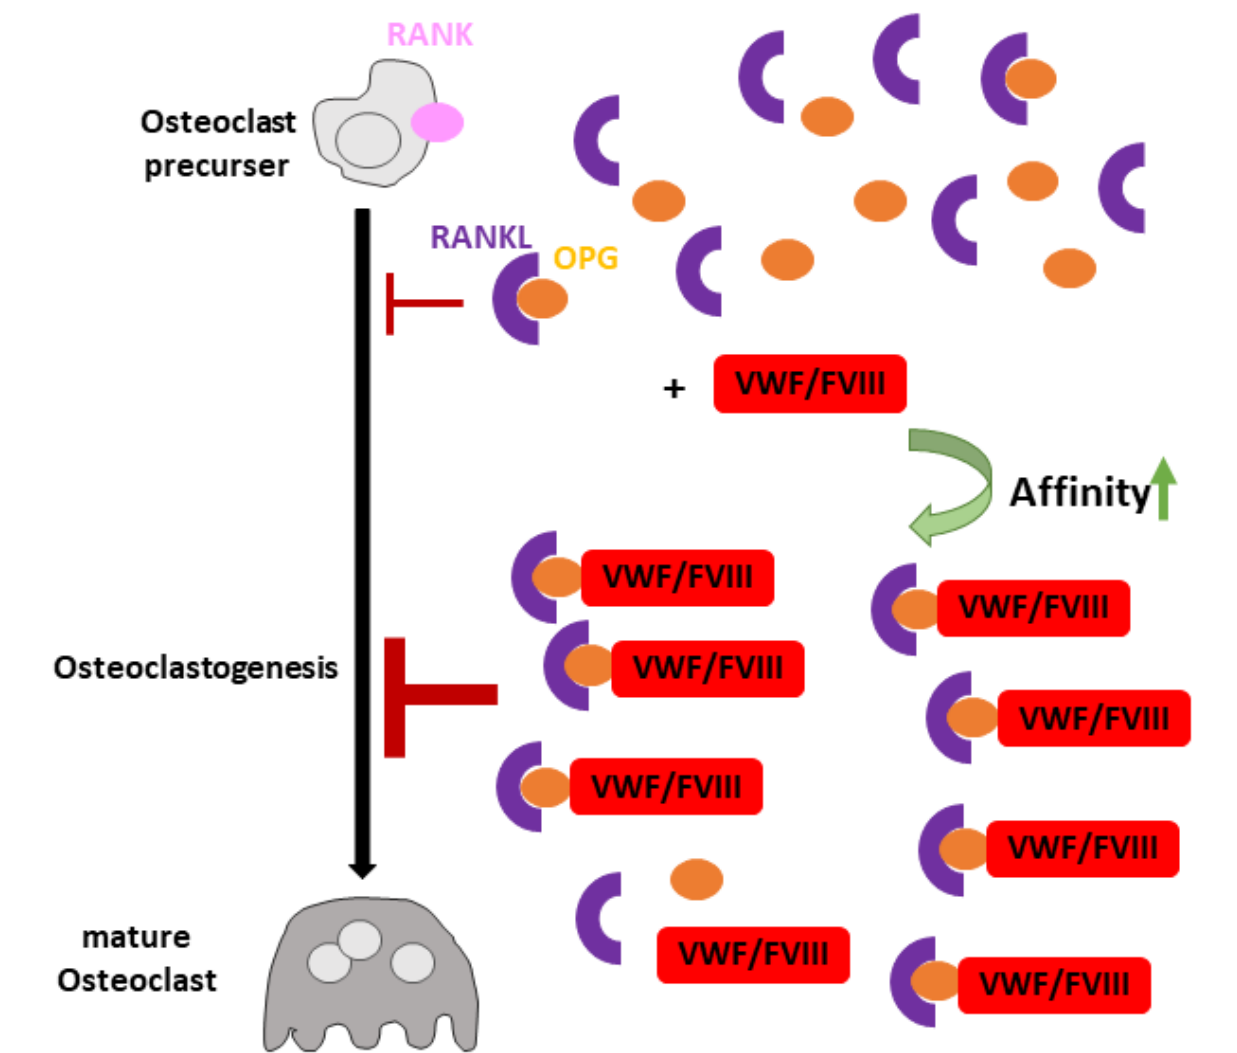
Figure 3. VWF’s role in osteoclastogenesis.In the absence of the VWF–FVIII complex (red), OPG (orange) binds to Receptor Activator of Nuclear factor κ B Ligand (RANKL, violet), leading to inhibition of osteoclastogenesis by preventing RANKL from binding to its receptor RANK (pink). In the presence of the VWF–FVIII complex, the affinity of OPG to RANKL is further increased, enhancing the inhibitory effect of OPG on osteoclastogenesis.